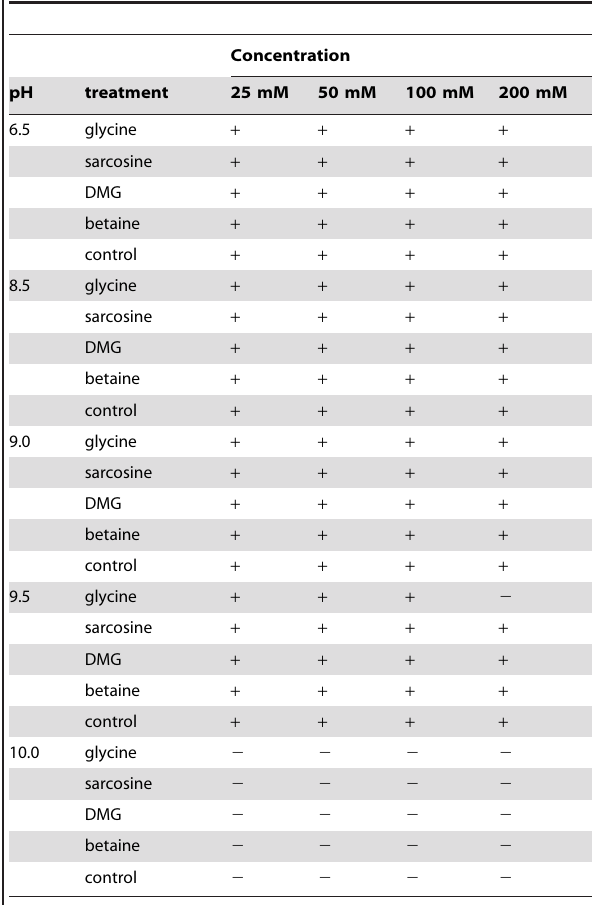
Table 1. Overview of the MIC determination data for glycine, sarcosine, DMG and